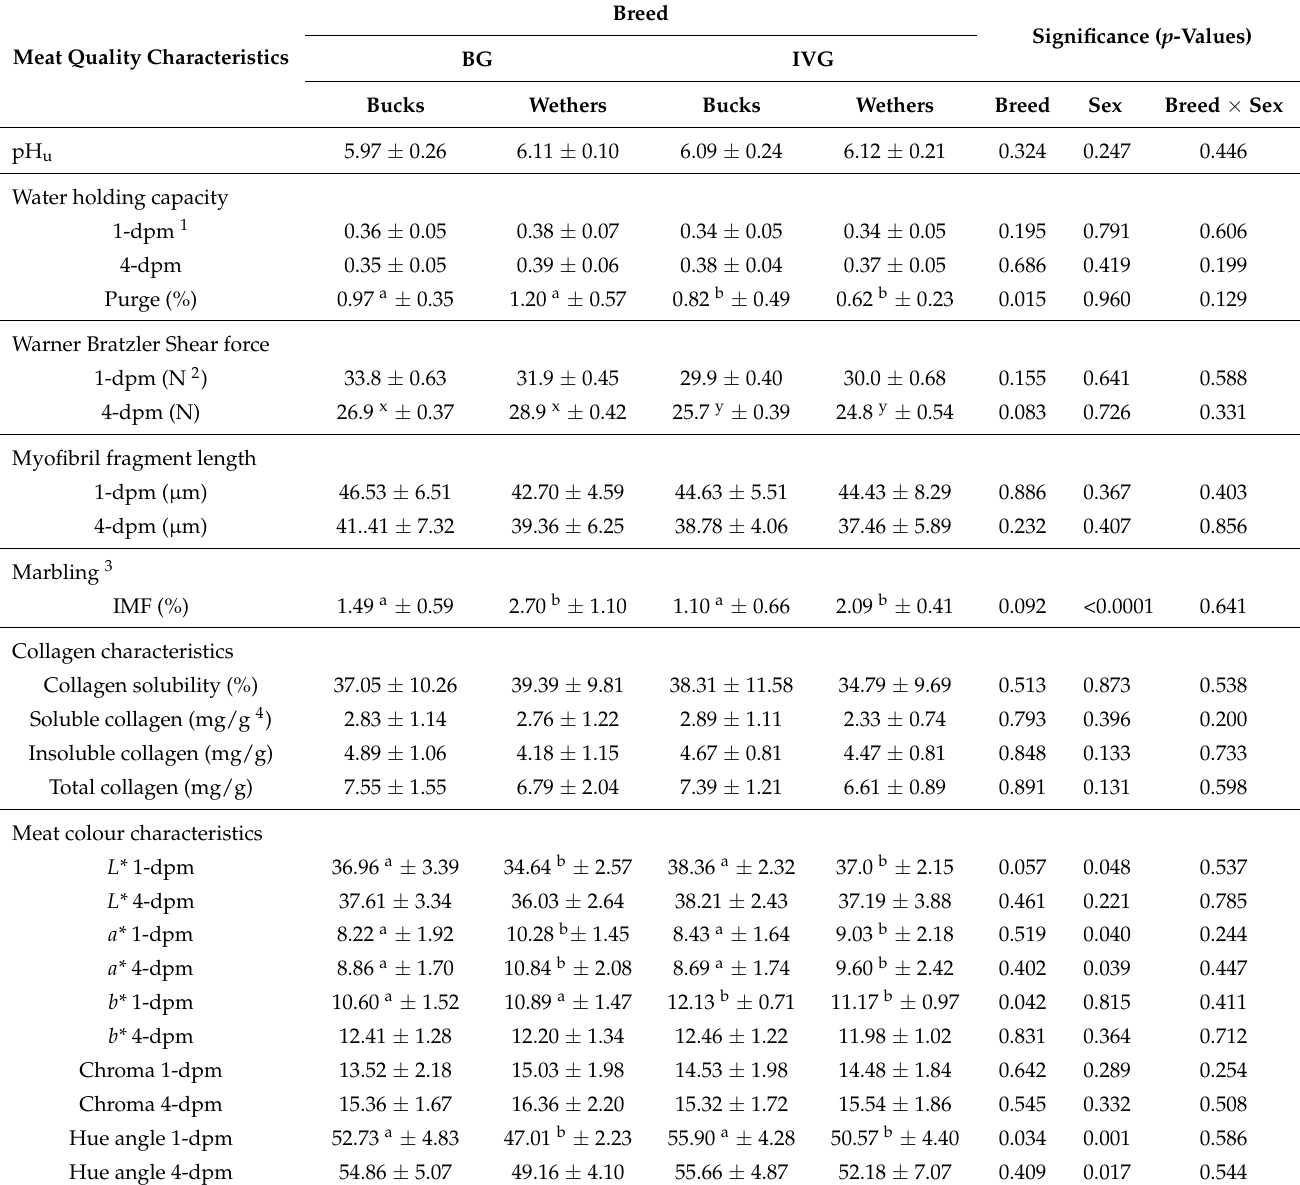
Table 6. Least square means and standard error of means for meat tenderness, meat colour and related physiological characteristics of buck and wether Boer Goats (BG) and Indigenous Veld Goats (IVG) of Infraspinatus (IS)